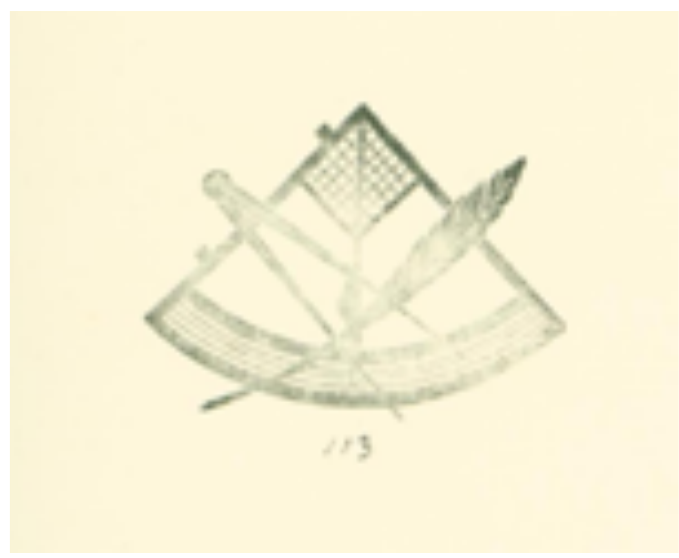
Fig. 9. Impression of finishing tool showing three masonic motifs